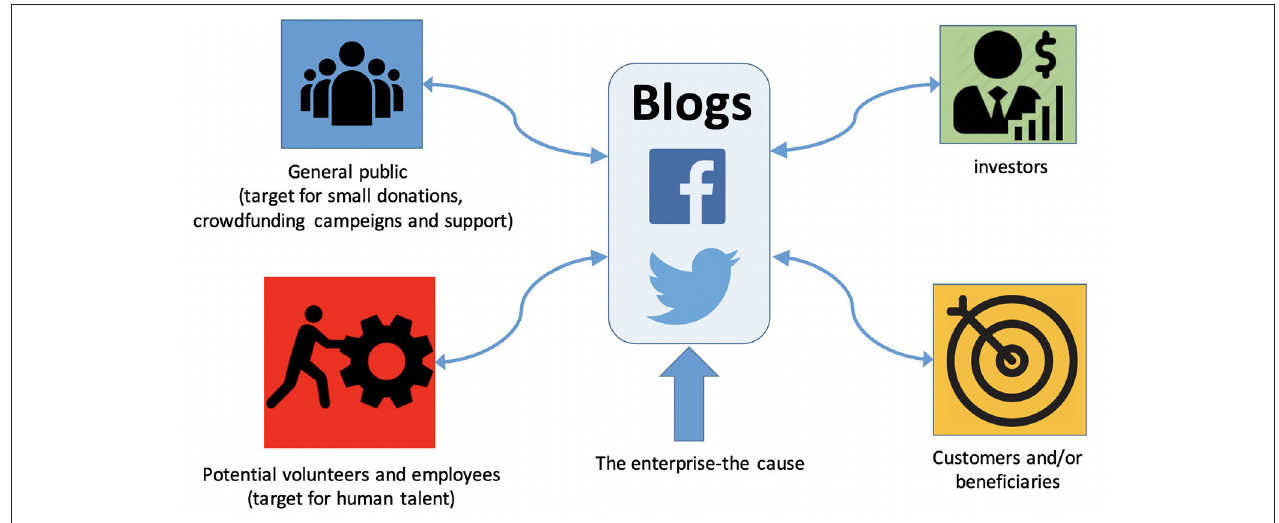
FIGURE 4 | Mass media and target publics for a social bioentrepreneur. Blogs and social media are the virtual/international headquarters of social bioenterprises, they are useful to engage (more than only communicate), to emphasize the cause and to show the strength of the community network. They also serve as platforms for interaction, and